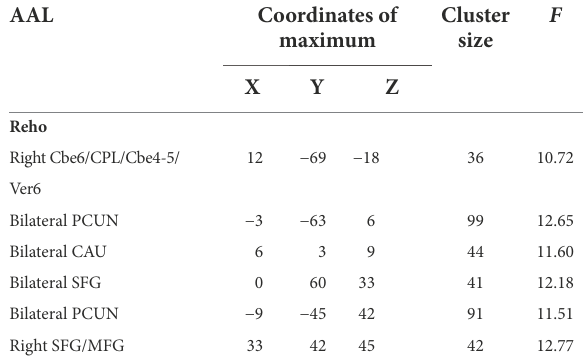
TABLE 2 Brain regions with significant differences in ReHo among the three